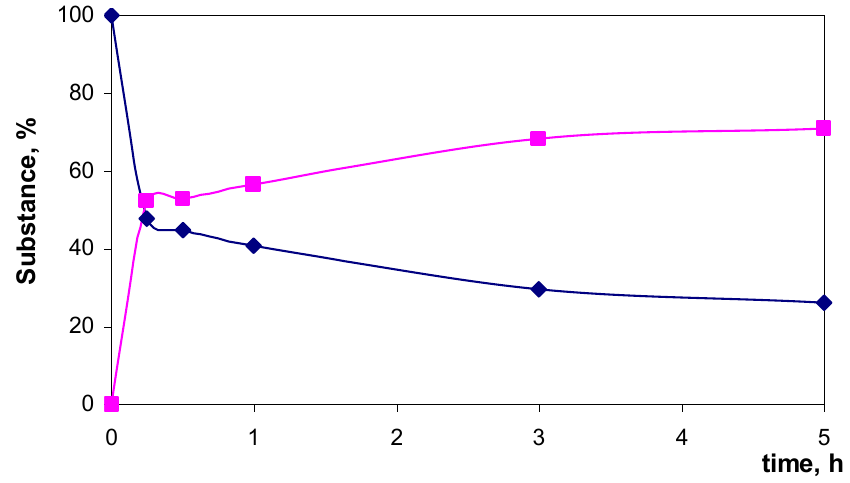
Fig. 3 Further alkylation of 3-butyl-indole ( 5 ) sodium salt with 1-iodobutane in [bmim] [Br] at 25 ◦ C, where: a) (cid:2) – 3-butyl indole; b) (cid:4) – 1,3 -dibutyl